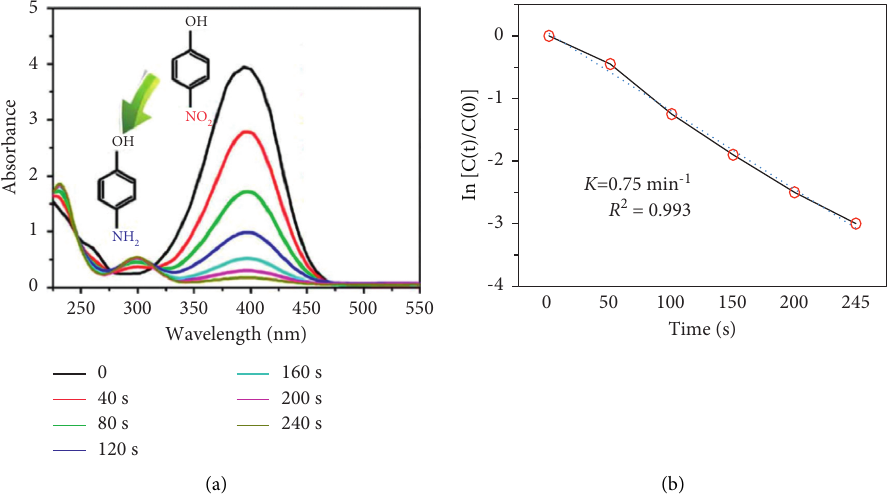
Figure 8: UV absorbance curves and catalytic time linear graph of sample 3 as catalyst: (a) UV absorbance curves; (b) relationship between ln[ C ( t )/ C (0)] and